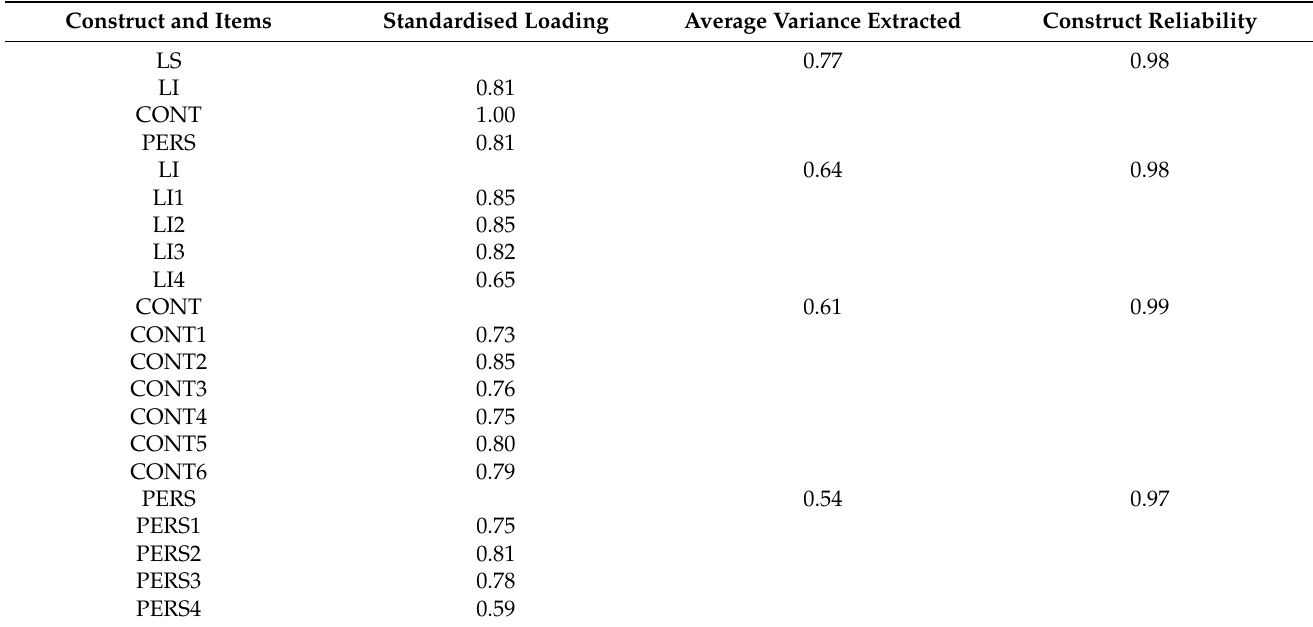
Table 6. Standardised loadings, average variance extracted, and construct reliability coefficients of the three-factor second-order